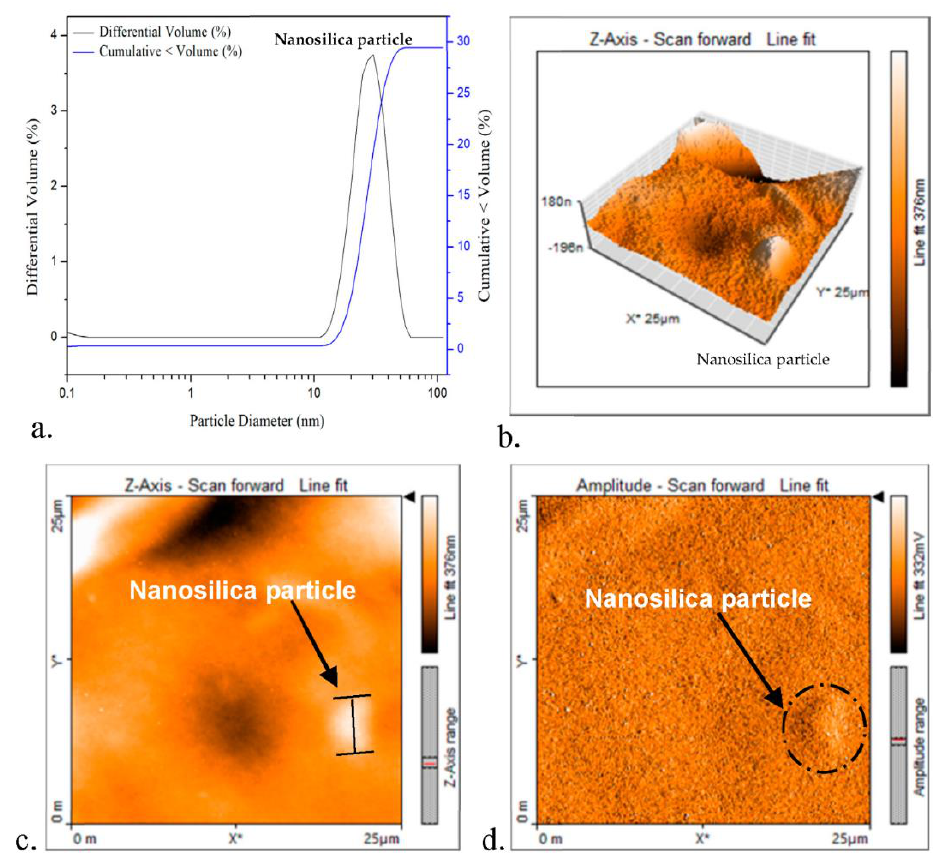
Figure 3. The particle size of nanosilica by DSL and AFM images: ( a ) particle size distributions by DSL, ( b ) 3-D topography images, ( c ) 2-D phase, and ( d ) nanoparticle phase separation by AFM technique, * in the figure as X axis scale or Y axis scale